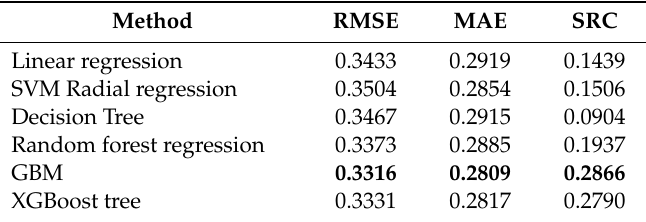
Table 4. Performance of di ff erent machine learning methods for Comments Prediction. Bold shows the best performance